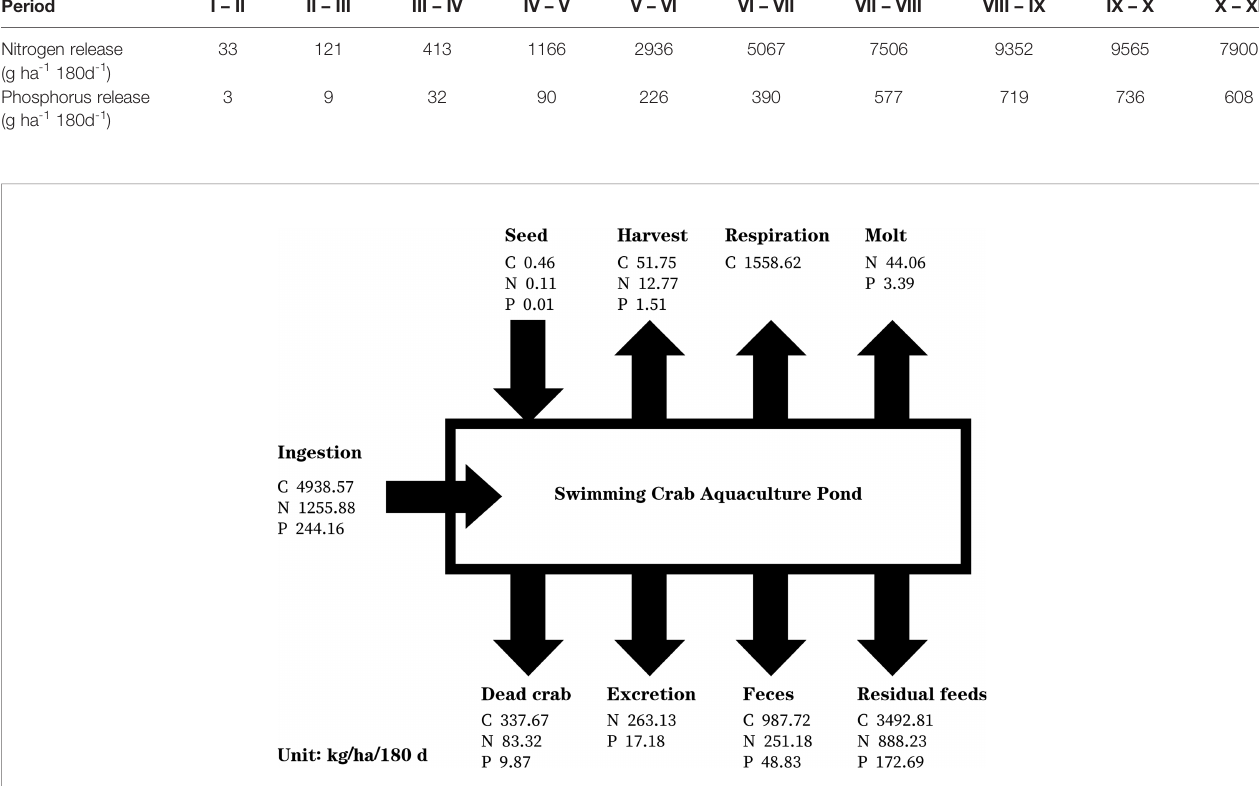
TABLE 4 | Carbon, nitrogen, and phosphorus released during the molting of Portunus trituberculatus . Period